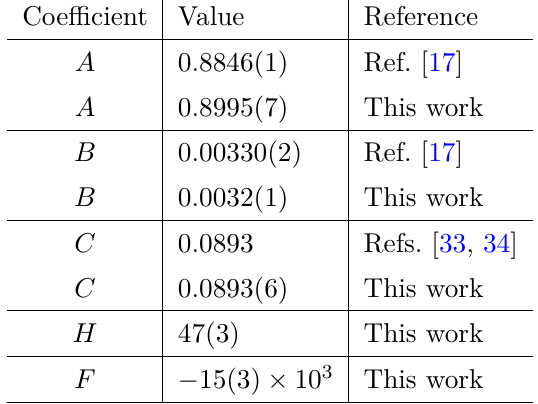
This work results for small µ . Using our conventions, c b